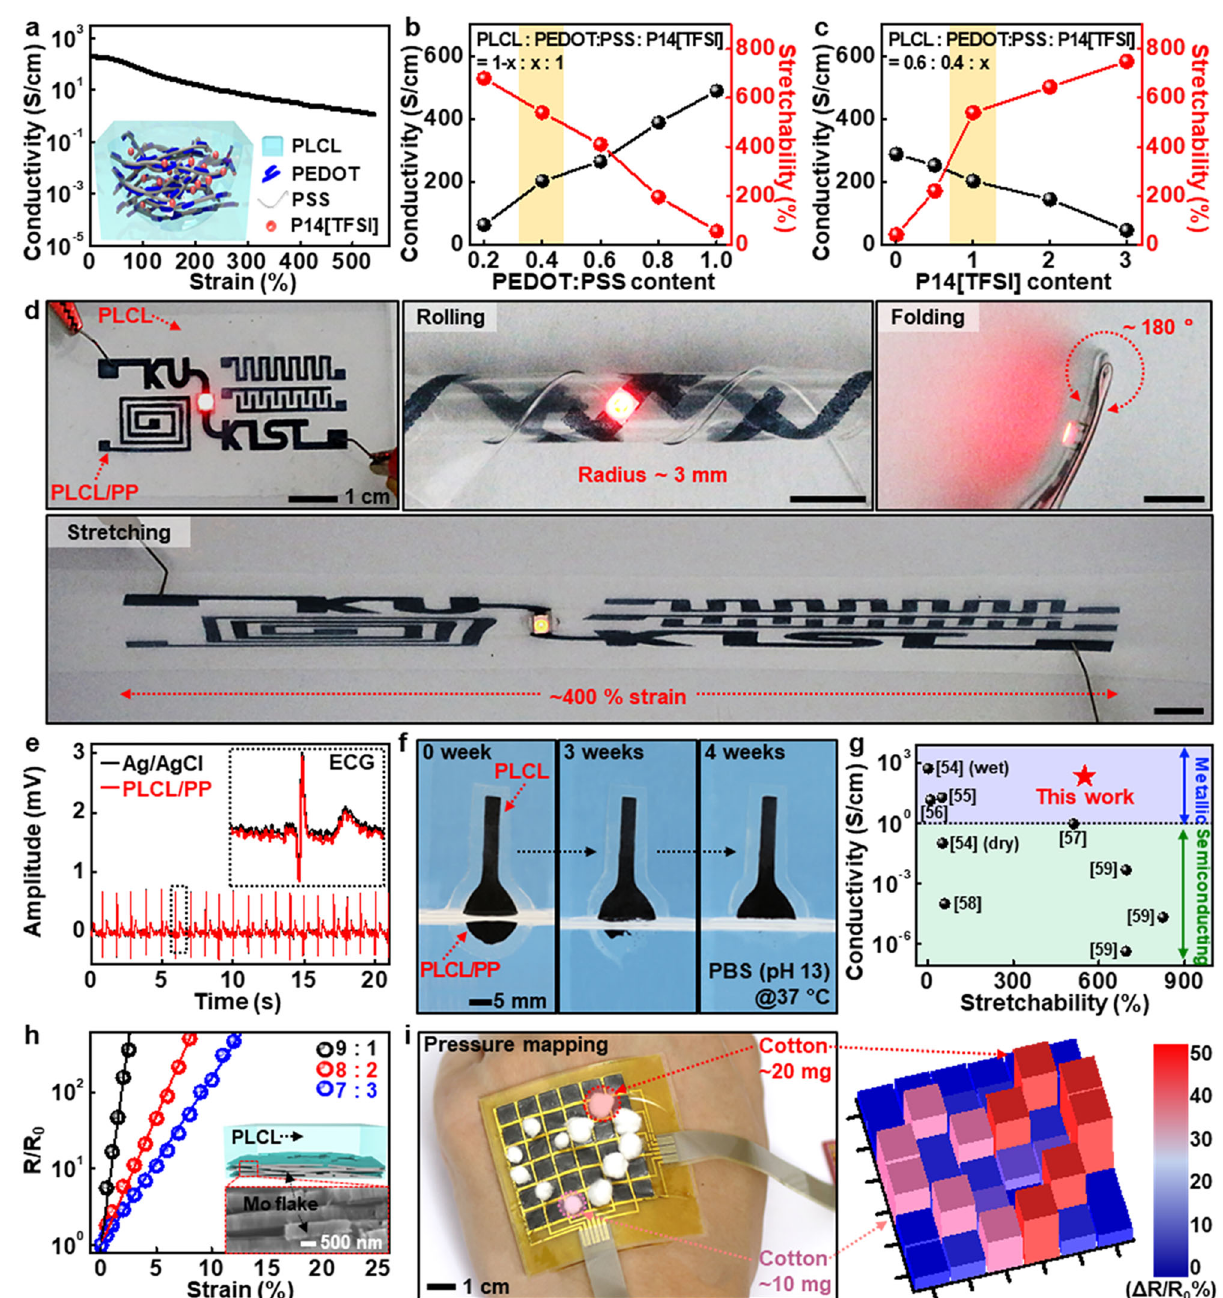
Fig. 3 | Different types of transient conductive elastomers with organic and inorganic fi llers. a Mechanical strain-dependent electrical characteristics of a partially biodegradable conductive elastomer comprised of PLCL as a polymer matrix,poly(3,4-ethylenedioxythiophene):poly(styrenesulfonate)(PEDOT:PSS)asa conductive fi ller, and N-methyl-N-butylpyrrolidinium bis(tri- fl uoromethanesulfonyl) imide ([P14][TFSI]) as a plasticizer and conductivity enhancer, and a schematic illustration of the PLCL/PEDOT:PSS elastic conductive composite (PLCL/PP) in the inset. b , c Dependence of conductivity and stretch- abilityofPLCL/PPonthecontentofPEDOT:PSS( b )andP14[TFSI]( c ). d Examplesof partially biodegradable composite (PLCL/PP)-based electronic components with various con fi gurations (top left); demonstrations of reliable and stable operations under various external deformations, rolling (top middle), folding (top right), and